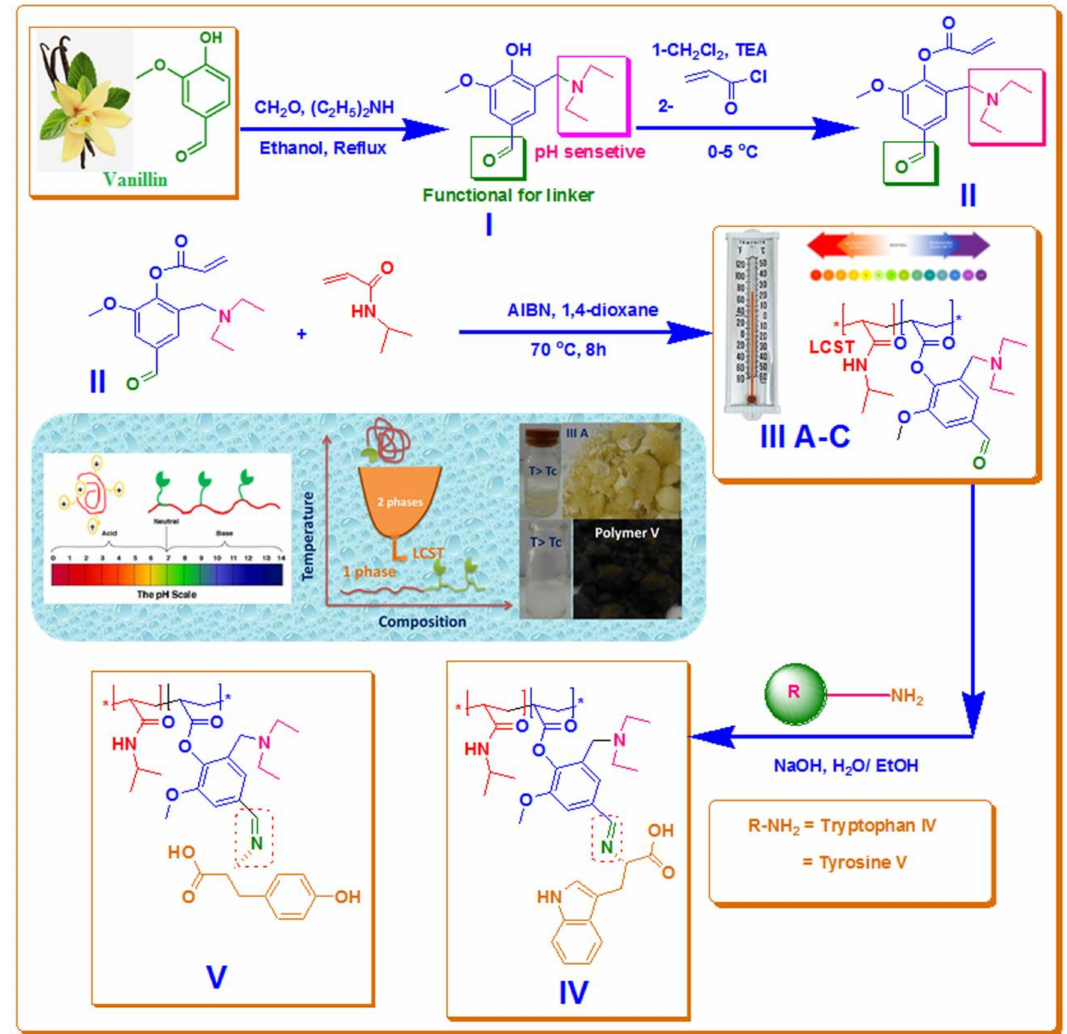
Figure 1. Synthesis of DEAMVA, copolymers and grafted polymers with